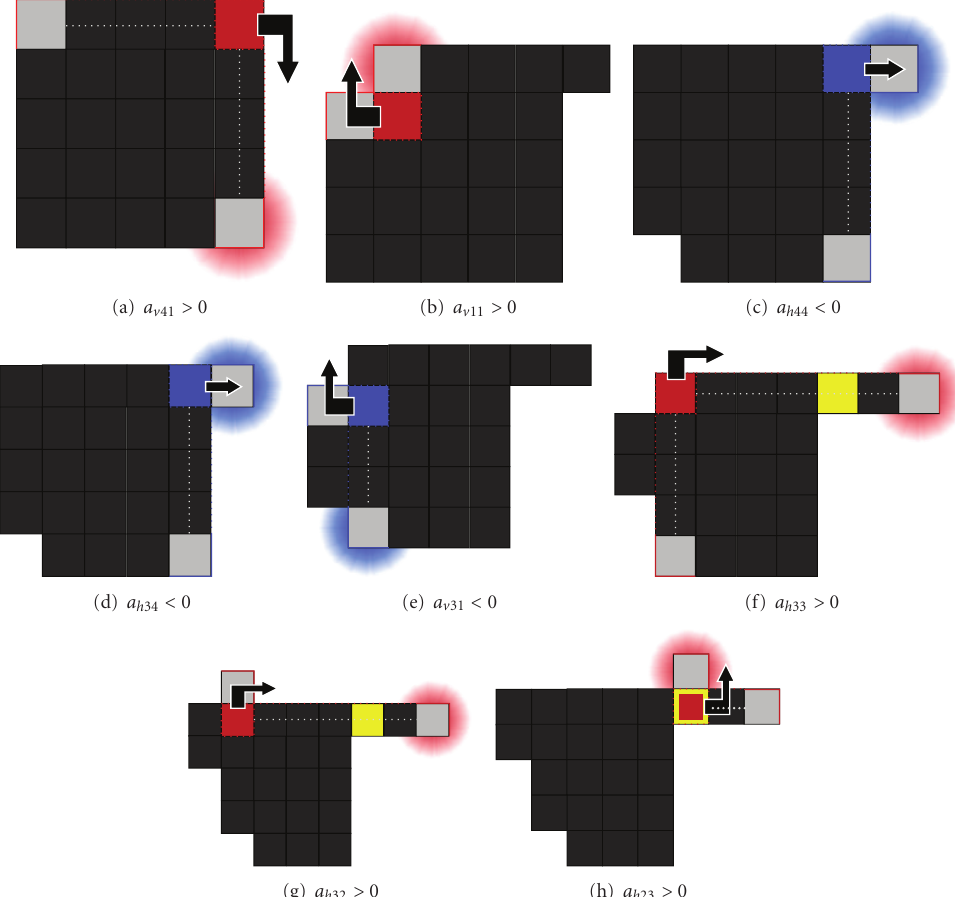
Figure 13: Transformation modes for adaptive cantilever construction.